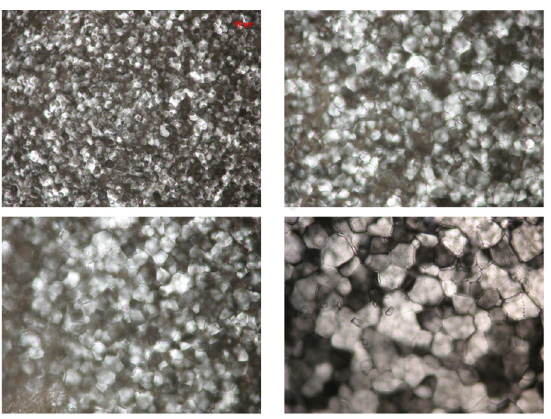
Fig 3. Splat frozen samples of S . feltiae extract (top row) and buffer control (25 mM Tris HCl, pH 8) (bottom row) after warming to – 8°C (Time 0 = left column) and after annealing at – 8°C for 30 min (right column). Scale bar = 100 μ m.